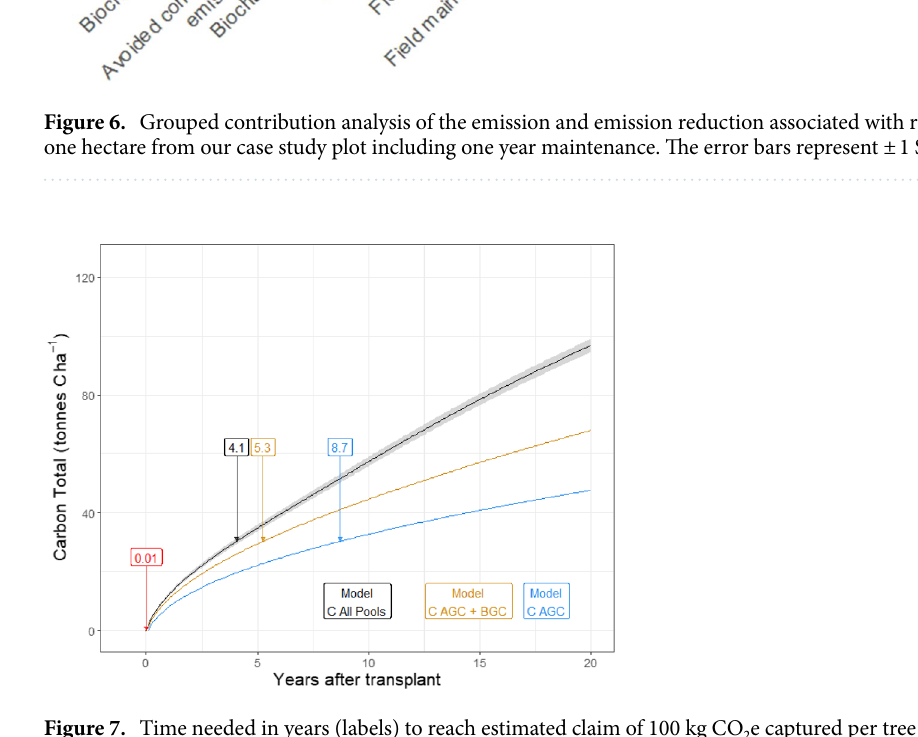
Figure 7. Time needed in years (labels) to reach estimated claim of 100 kg CO 2 e captured per tree using our model considering all C pools (black), above and below-ground C pool only (yellow), and above-ground C pool only (blue). The red label represents the time in years necessary to offset the emissions associated to set up the plot. The ribbon around the model carbon capture rate is ± 1